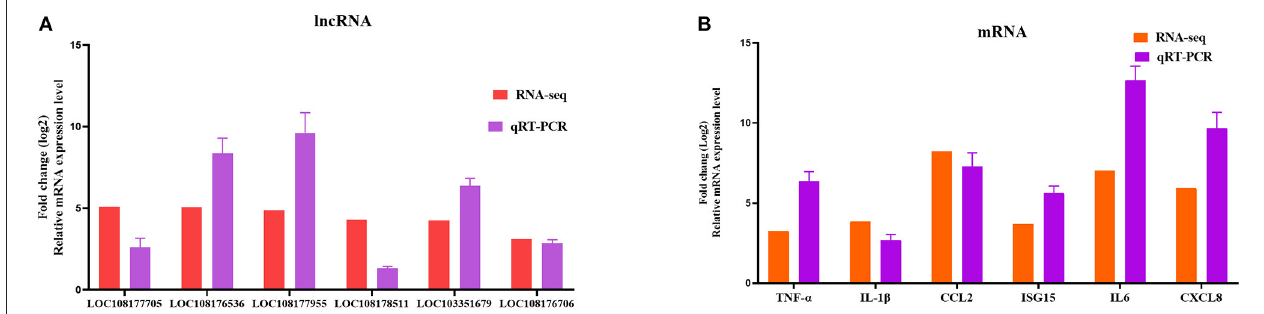
FIGURE 6 | Validation of the RNA-seq results by qRT-PCR. Six DE lncRNAs (A) and mRNAs (B) that participated in immune-related events were picked for qRT-PCR analysis, and expression was quantized using the 2 − 11 CT method. Data for five independent trials were exhibited as mean ±